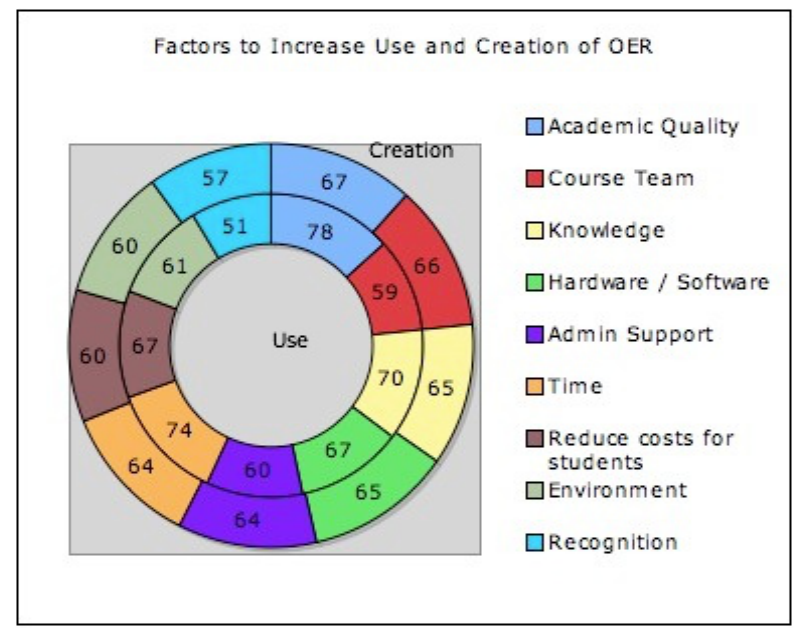
Figure 1. Factors to increase use and creation of